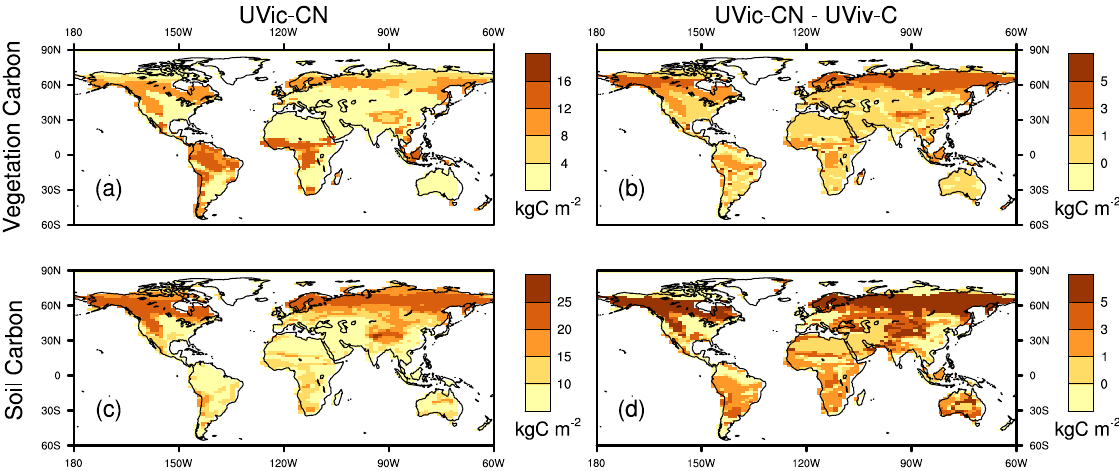
Fig. 7. Mean 1980–1999 carbon content in vegetation (a) and soil plus litter (c) for the UVic-CN simulation (left) and the difference between UVic-CN and UVic C-only (right) for vegetation (b) and soil plus litter (d) .